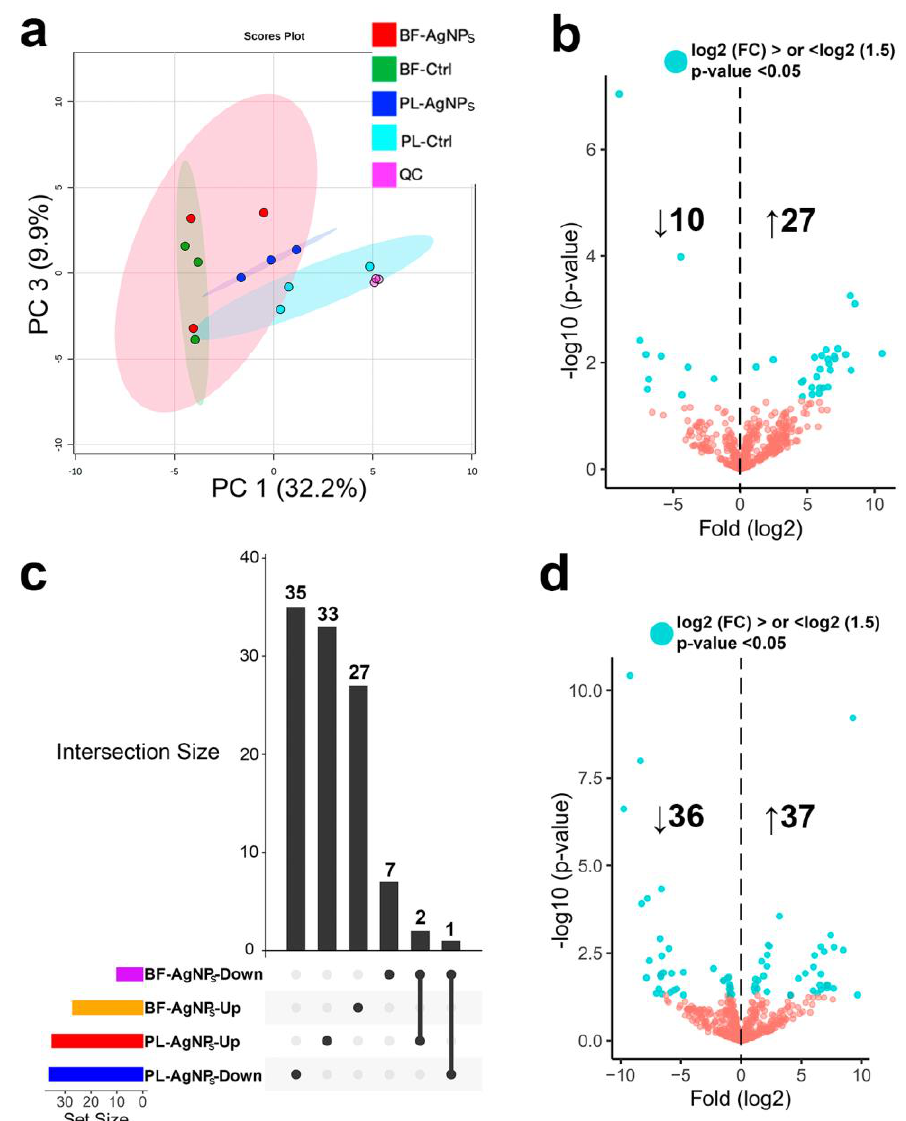
Figure 3. Mass spectrometry-based untargeted metabolomics and chemoinformatic analyses of planktonic cell (PL) and biofilm (BF) V. cholerae exposed to silver nanoparticles (AgNPs). ( a ) Principal Component Analysis (PCA) using the aligned and filtered features among the groups. Data as log-transformed without scaling. Shaded areas denote 95% confidence intervals. Volcano plot of the quantified features in ( b ) biofilm (BF-AgNPs/BF-Ctrl) and ( d ) planktonic (PL-AgNPs/PL-Ctrl) V. cholerae exposed to AgNPs. Blue dots indicate features significantly modulated by AgNPs treatment based on fold-change and p -value (Limma test) criteria. ( c ) Overlapping pattern (Upset plotting) of dysregulated metabolites by AgNPs under conditions where the interconnected points between the groups indicate that 3 of the 105 perturbed metabolite features were shared.